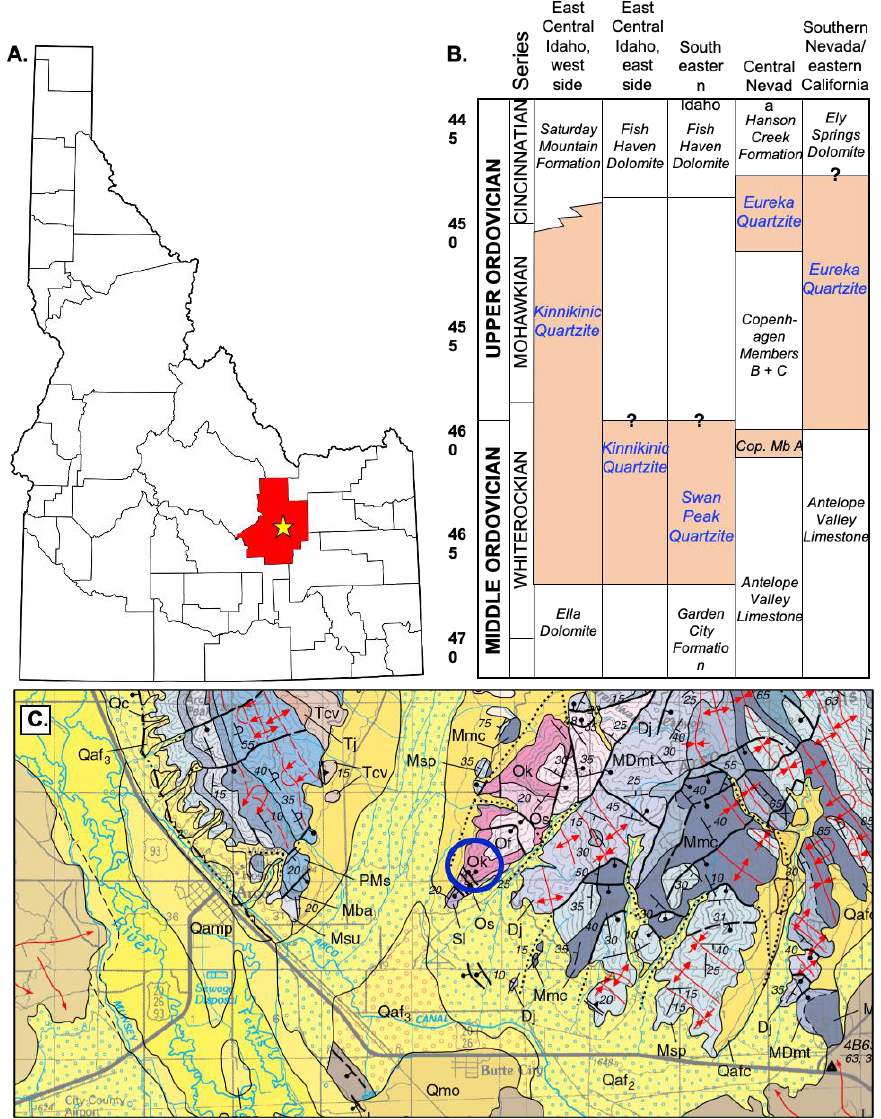
Figure 1. ( A ). State map showing the general location of the proposed Arco Hills Silica and Gold Project (AHSGP) in Butte County, Idaho [25]. ( B ). Regional Paleozoic stratigraphy for the study area [24]. ( C ). Geological map [26] of the Arco region with the sample site in the Middle Ordovician Kinnikinic Quartzite (Ok) unit identified by the blue circle (43.639091°, − 113.243295°).